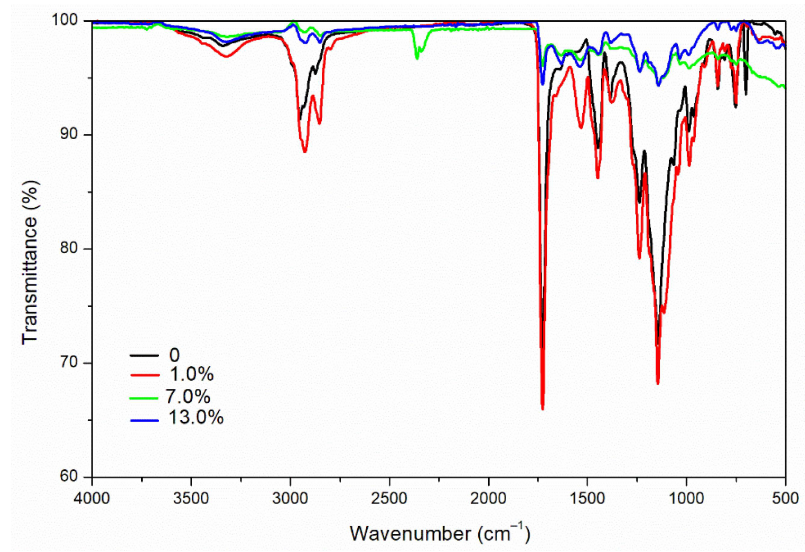
Figure 4. Infrared spectroscopy of microencapsulated incorporated waterborne coatings with differ- ent discolouring powder microcapsule